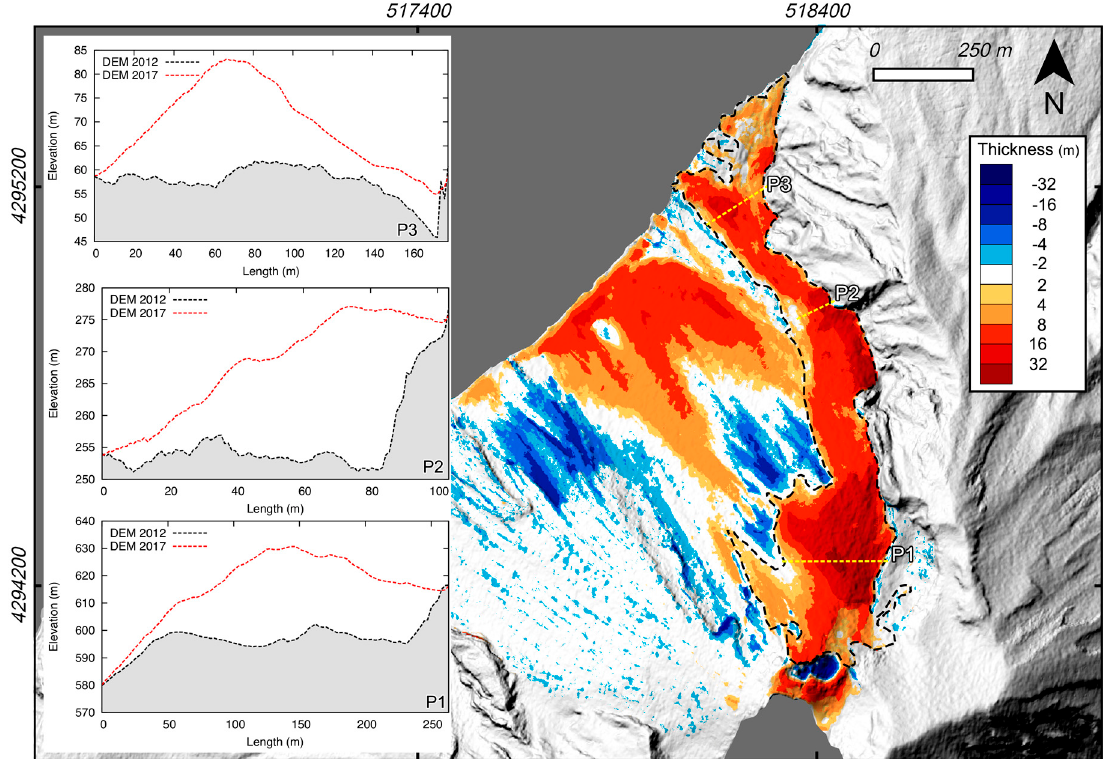
Figure 9. Stromboli topographic changes detected comparing 2012 and 2017 DEMs. Dashed black line encloses the area covered by the 2014 lava flow. Dashed yellow lines, labelled with P1, P2 and P3, show the position of the profiles along the flow represented in the insets.